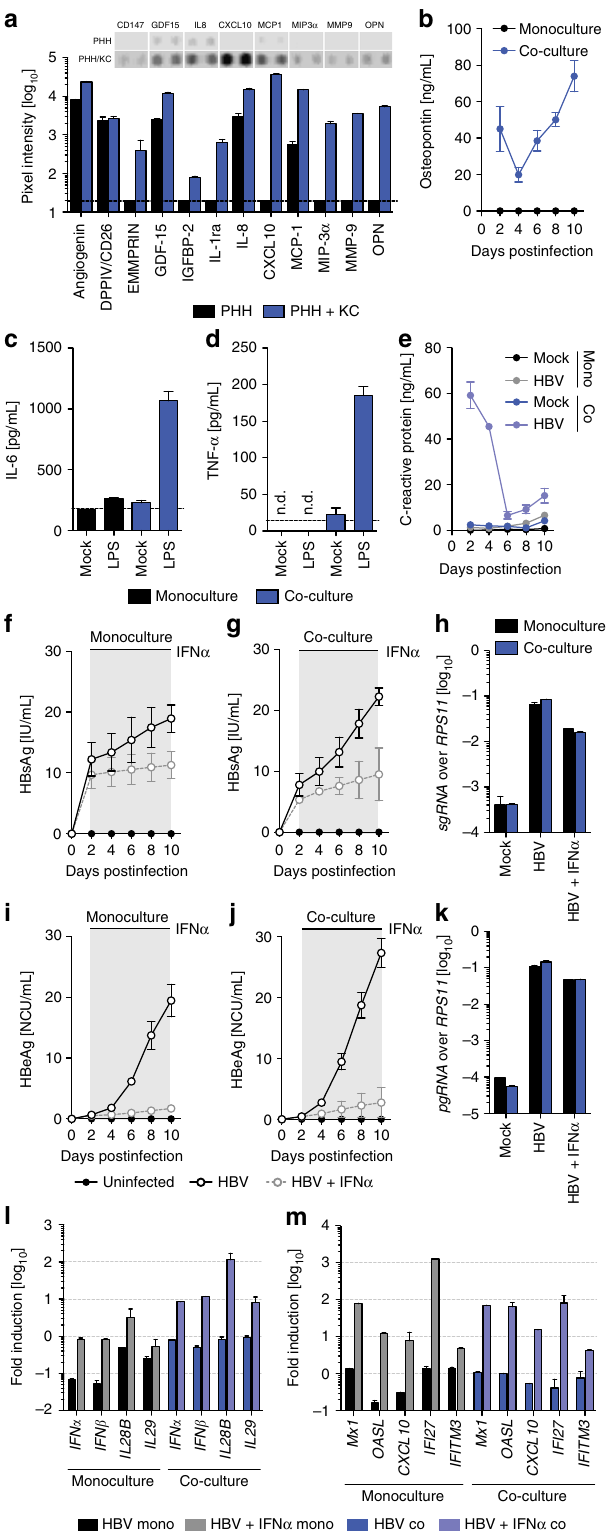
Cytokine XL antibody array of 3D PHH and 3D PHH/KC co-cultures (ratio 10:1) 13 days post-seeding. b Longitudinal osteopontin protein levels in 3D PHH and 3D PHH/KC co-cultures, determined by Luminex. c , d Response of 3D PHH and 3D PHH/KC co-cultures to 1 μ g/mL LPS added 11 days post- seeding as determined by measurement of c IL-6 and d TNF- α 24 h